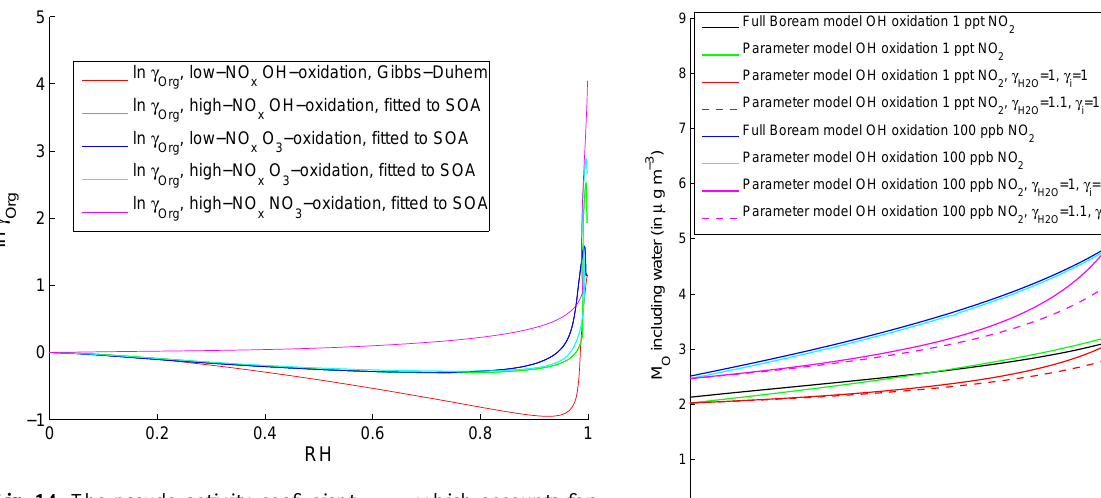
Fig. 14. The pseudo-activity coefficient γ Org , which accounts for the non-ideality effects of water on the organic fraction (at 288K). For low-NO x OH-oxidation it is derived based on the Gibbs-Duhem equation (red curve). For the other scenarios, the use of this γ Org based on Gibbs-Duhem does not always lead to a satisfactory agree- ment between full BOREAM SOA yields and the parameterisation. Therefore γ Org values derived by a direct fitting in order to opti- mise M O agreement between full BOREAM and parameter model are used (other curves).